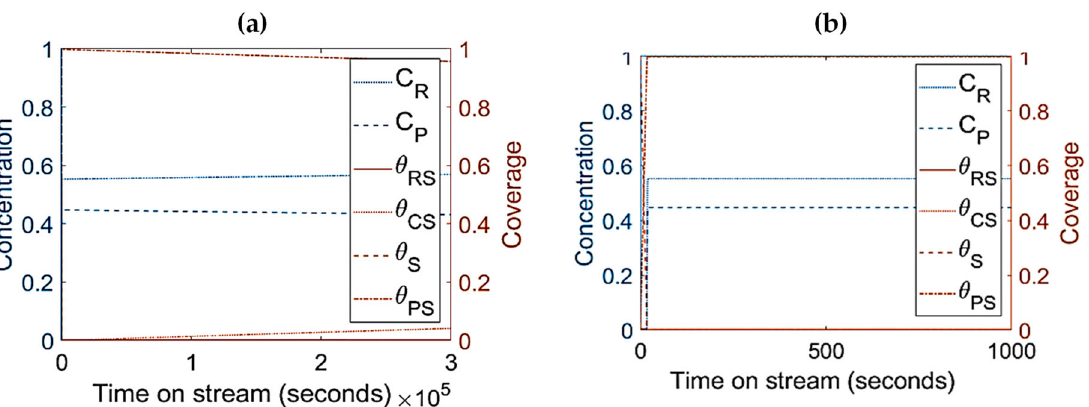
Figure 8. Estimated reactant and product concentration profiles ( left axis ) and surface species coverages ( right axis ) with respect to time: sensitivity analysis for Mechanism IV, ( a ) elementary model, using parameters values in Tables 1 and 2 ( b ) with decreased k − C by 10 − 5 and k C